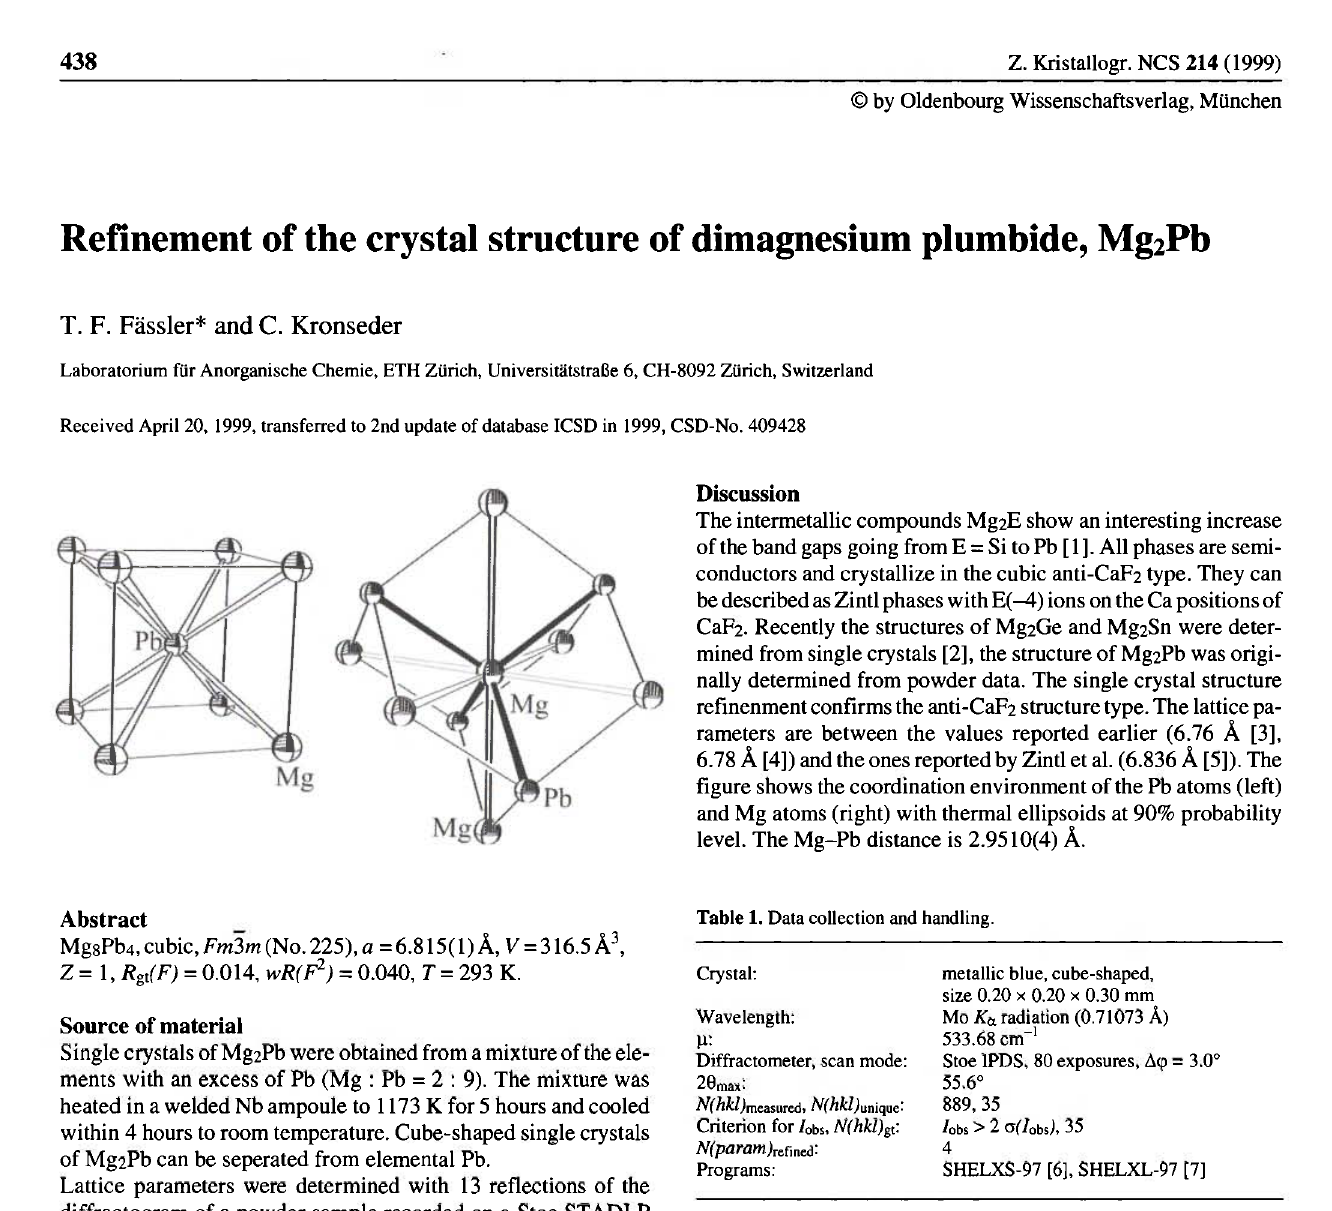
Table 2. Atomic coordinates and displacement parameters (in Ä 2 ).